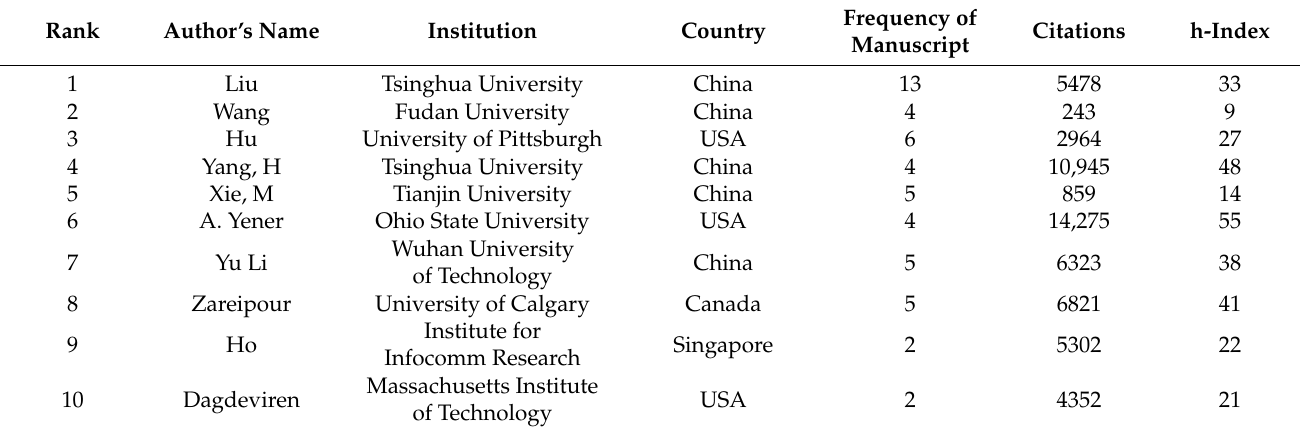
Table 7. Top 10 authors with 2 or more published manuscripts.